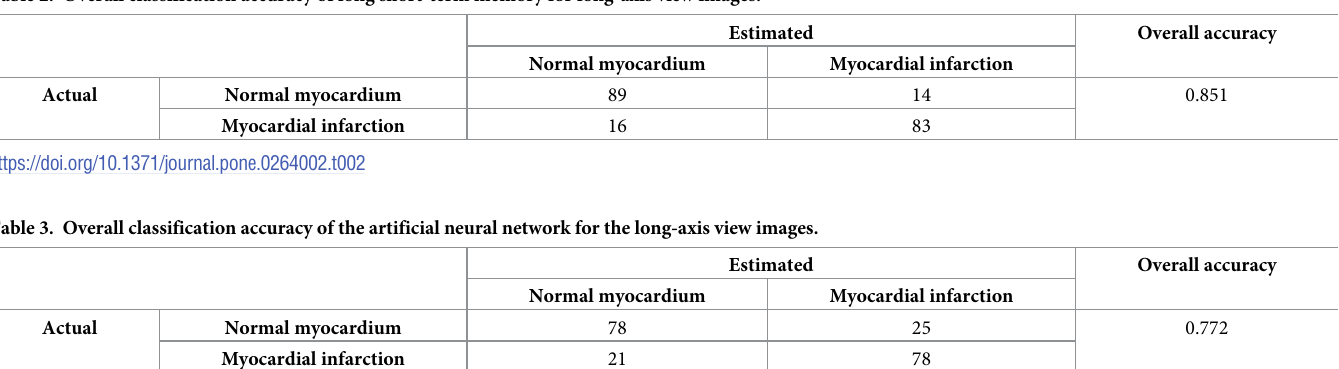
Table 2. Overall classification accuracy of long short-term memory for long-axis view images.